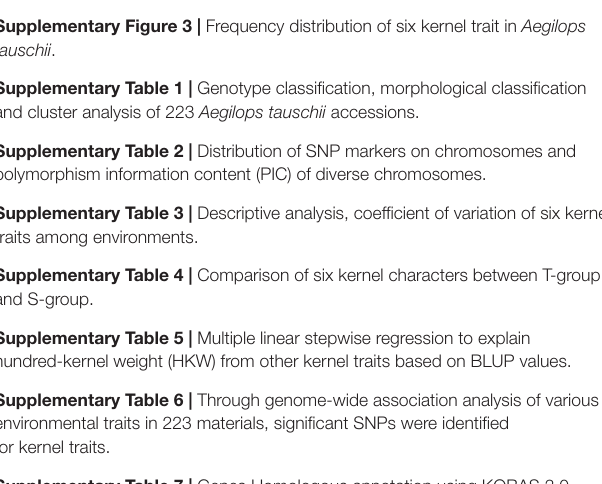
Supplementary Figure 2 | Linkage disequilibrium (LD) decay plot for T-group and S-group. Supplementary Figure 3 | Frequency distribution of six kernel trait in Aegilops tauschii .